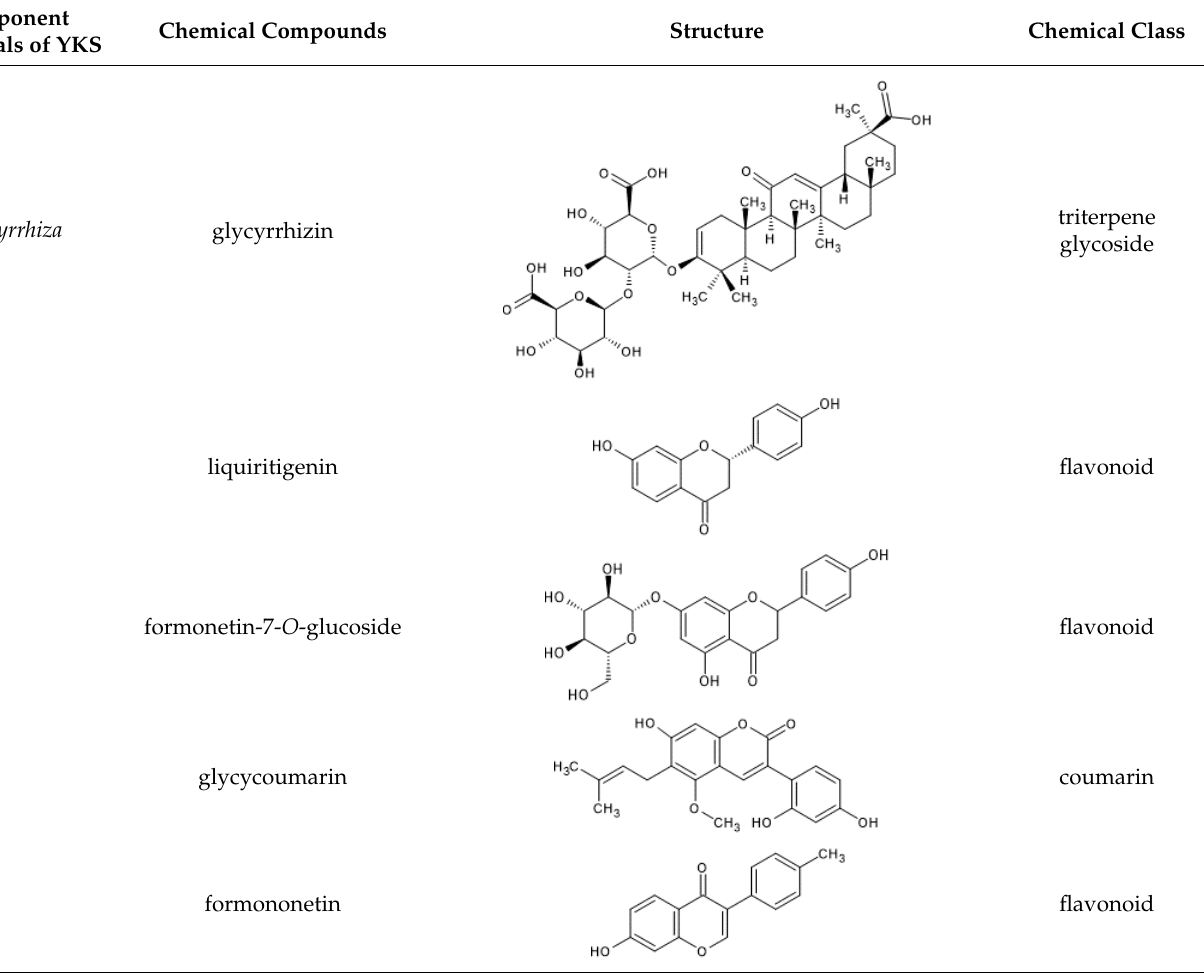
The chemical compounds identified in the three-dimensional high-performance liquid chromatog- raphy profile chart (Figure 1), their structures, and chemical classes are shown. (*) Ligustilide is included in Cnidium Rhizome and Japanese Angelica .